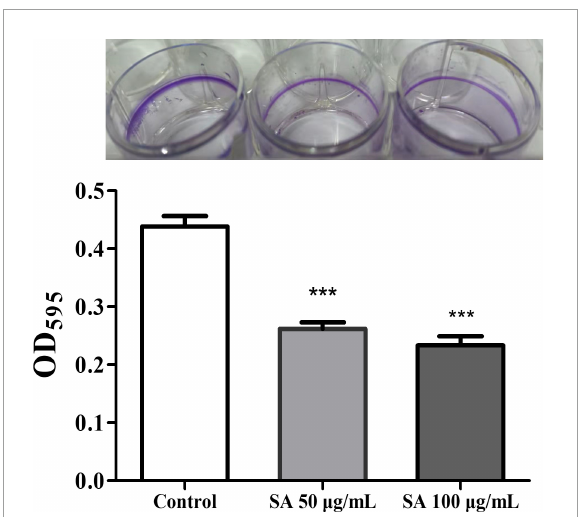
FIGURE5 Impact of SA on the biofilm formation of PAO1. All data were expressed as mean ± SD values with three independent experiments performed in triplicate. *** p <